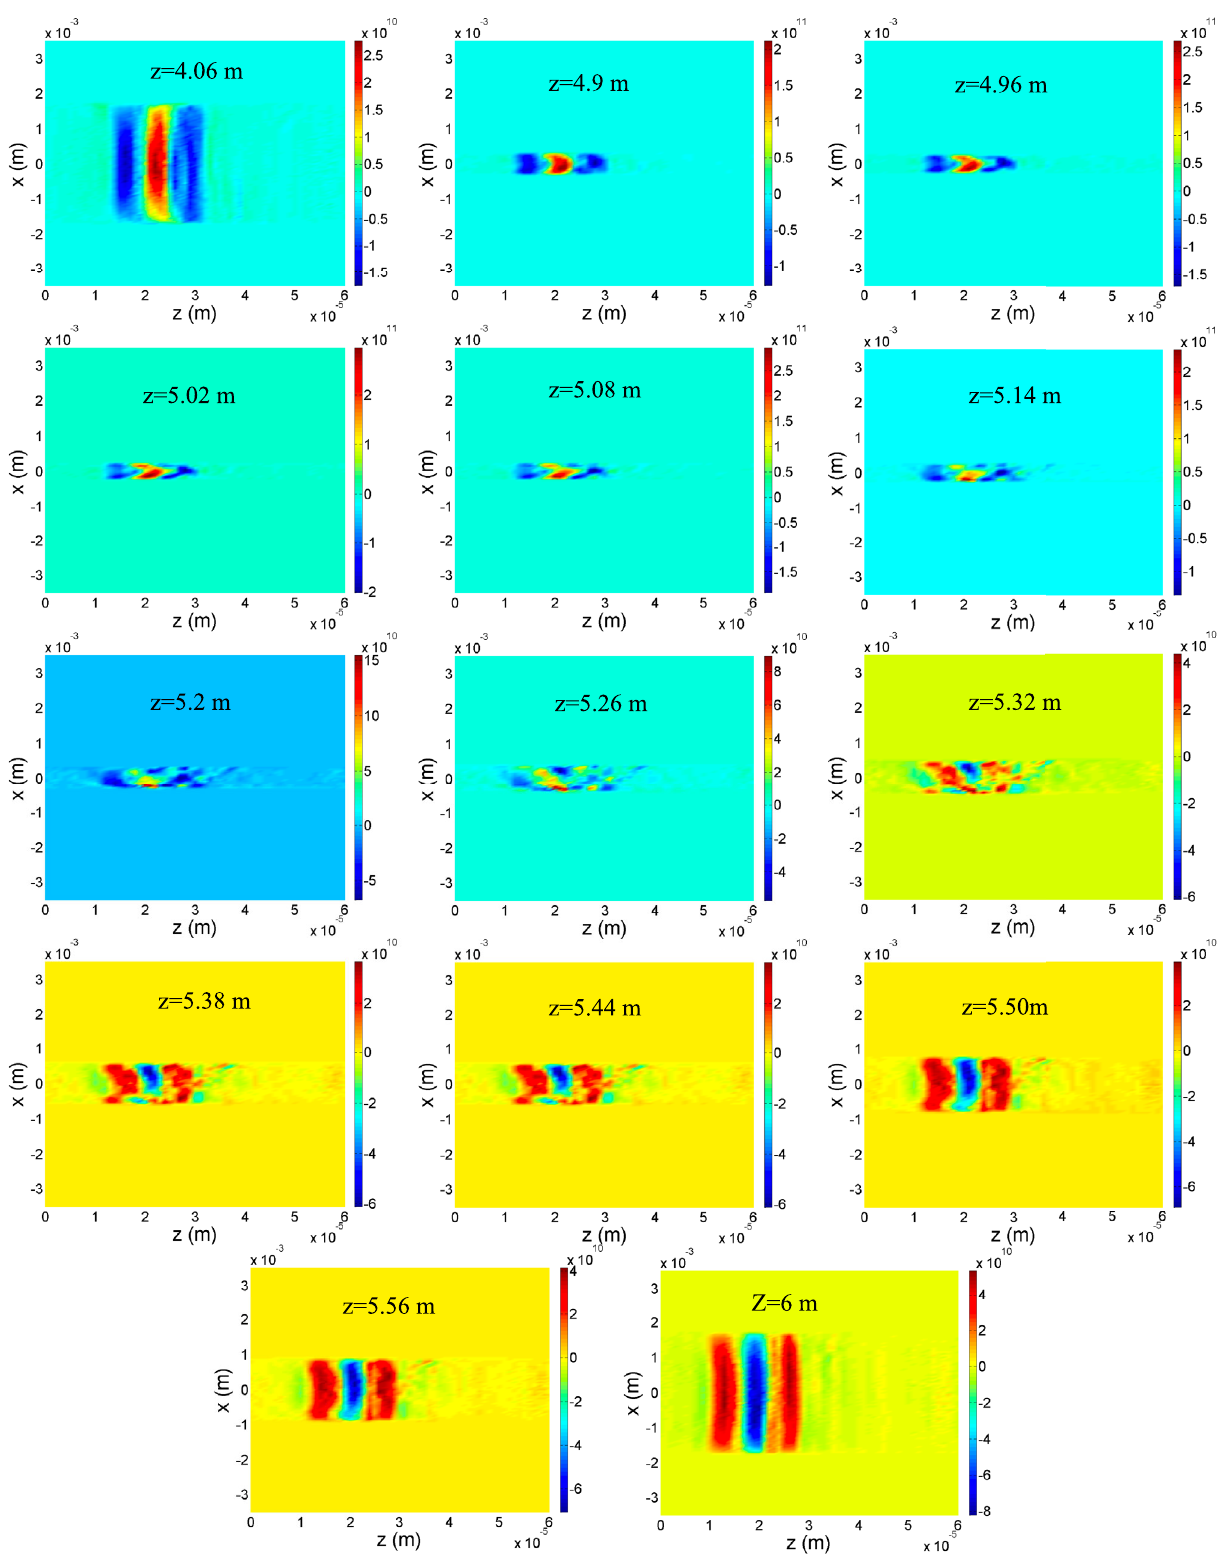
FIG. 11. Case 1: evolution of the single spike in density modulation in the third cell of the test PCI lattice. Fragmentation into multiple modes is visible at z ranging from 5.05 to 5.5 m. The sign of the density modulation for the central slice flipped again, and has the same sign as the first cell, but with tenfold larger